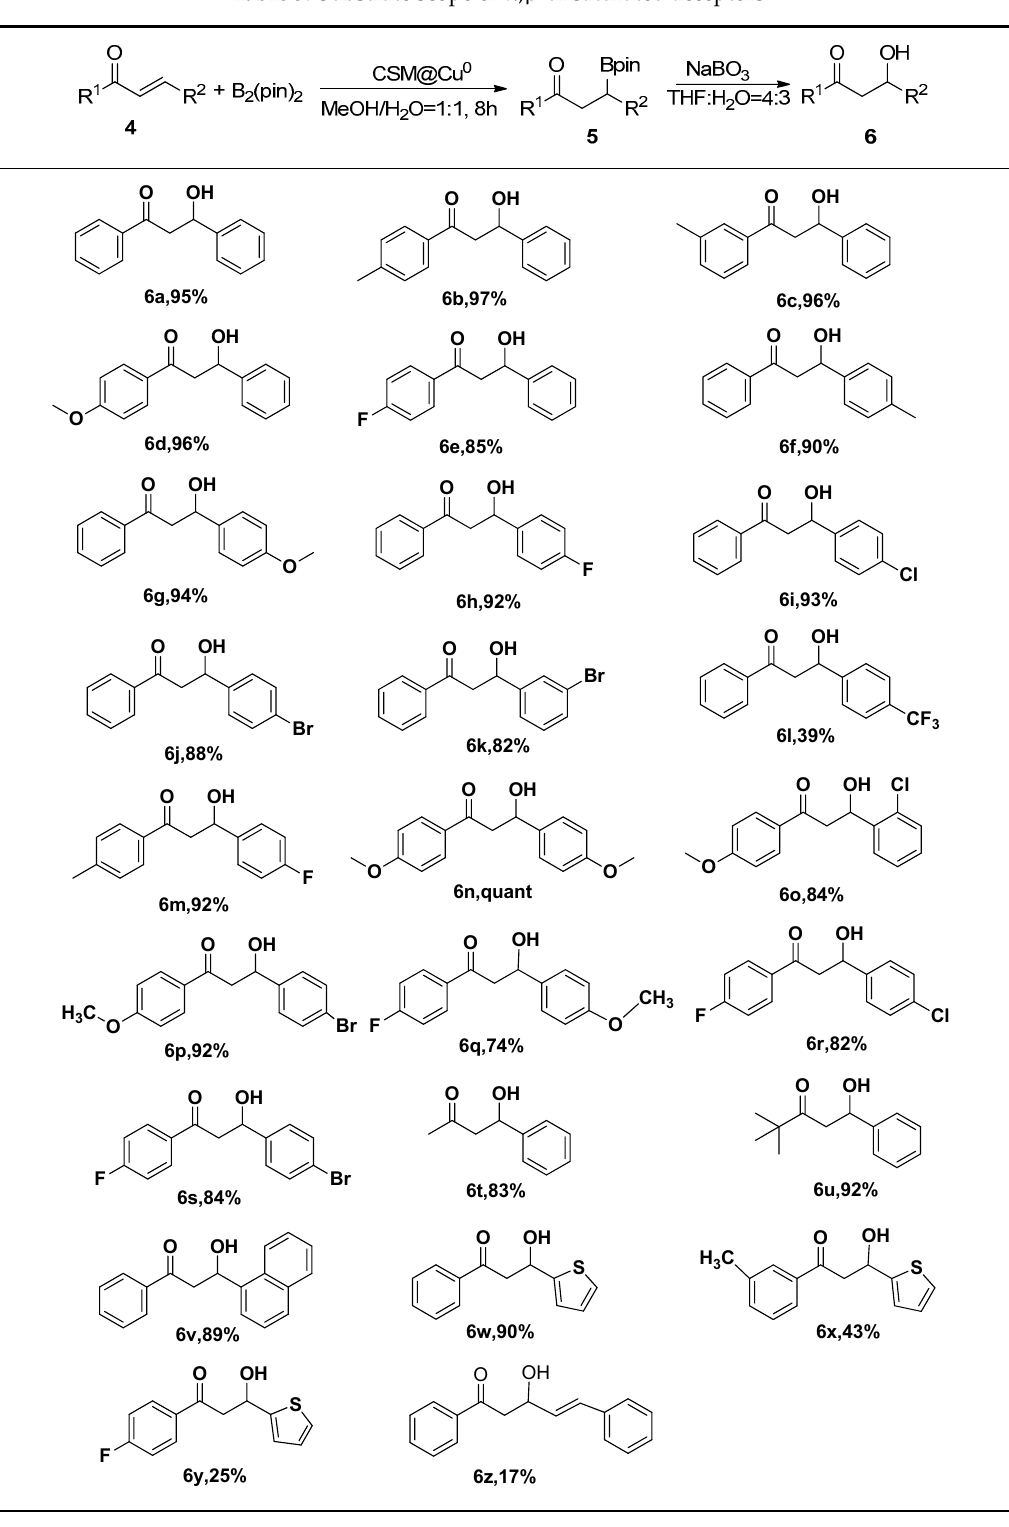
Table 3. Substrate scope of α , β -unsaturated acceptors.